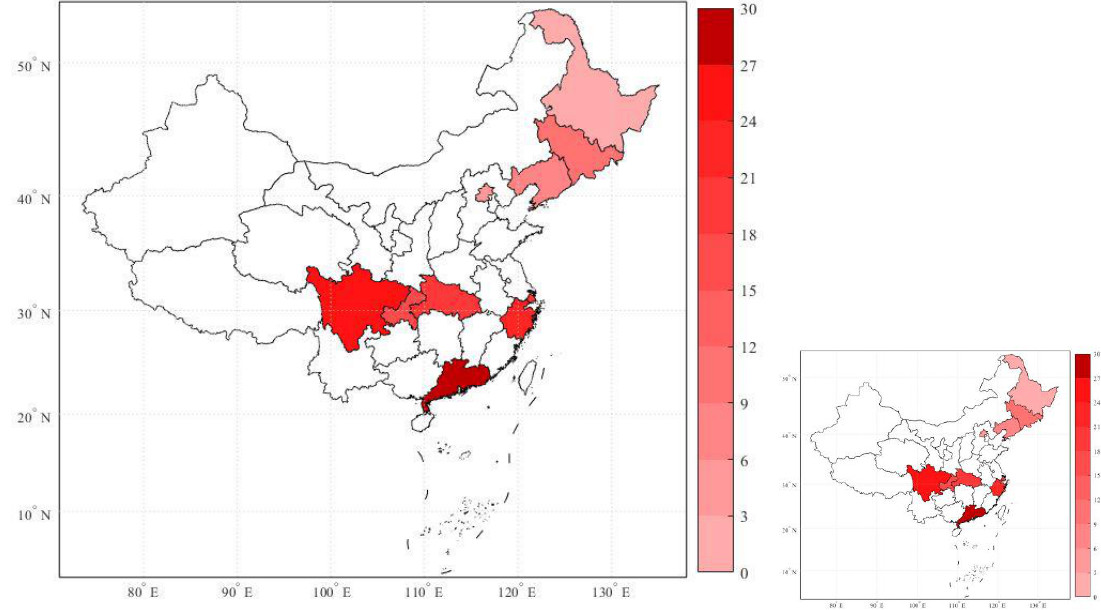
Figure 1. Geographical distribution of the annual average nasopharyngeal carcinoma (NPC) incidence of the ten large Chinese cities, from the period 2006 to 2013. Note: The color-bar on the right represents different degrees of NPC incidence—the deeper the red color, the higher the incidence.